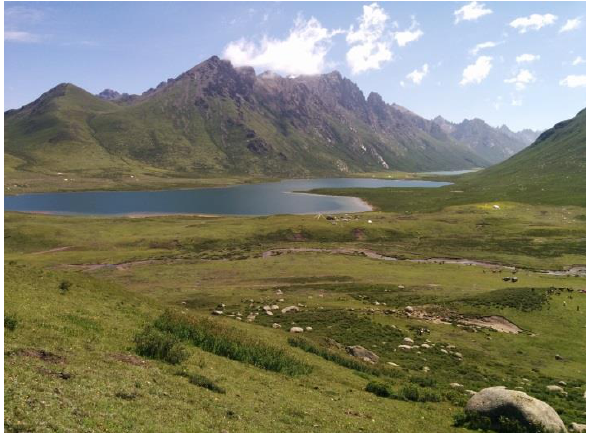
Figure 1. Typical vegetation cover of grass land and topography in the study area (source: A.